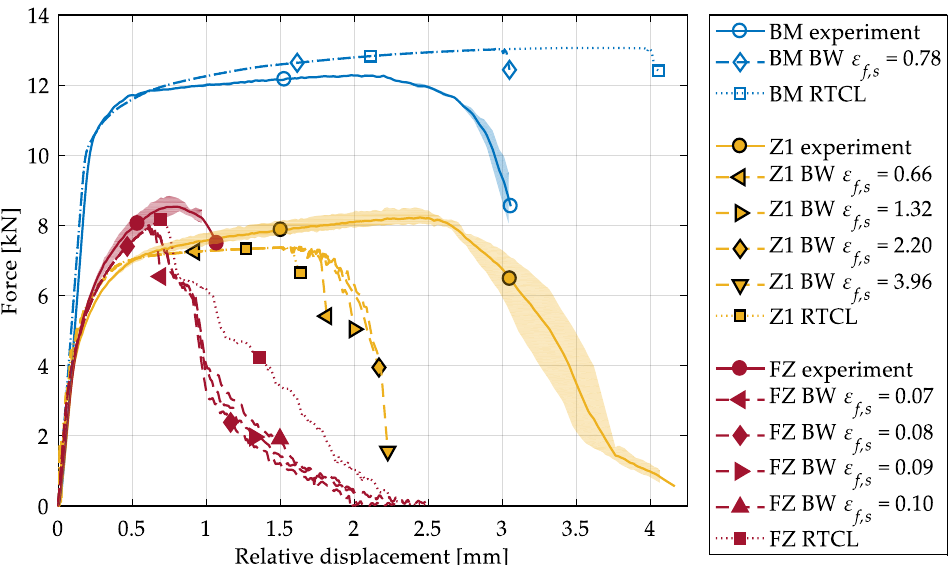
Figure 8. Force – displacement curves of shear tests obtained by experiments and numerical simulations with both fracture criteria (dotted: RTCL and dashed: BW) for three material zones. The experimental results (solid lines) are shown with their respective scatter band. 𝜀 𝑓,𝑢𝑡 is the constant value obtained from tensile tests during variation of 𝜀 𝑓,𝑠 . The simulation with the parameters displayed in Table 1 for the BW criterion is marked with a diamond. Materials 2020 , 13 , x FOR PEER REVIEW 10 of 24